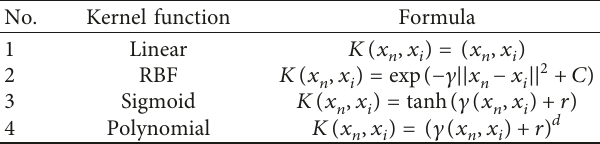
Table 1: Different kernel